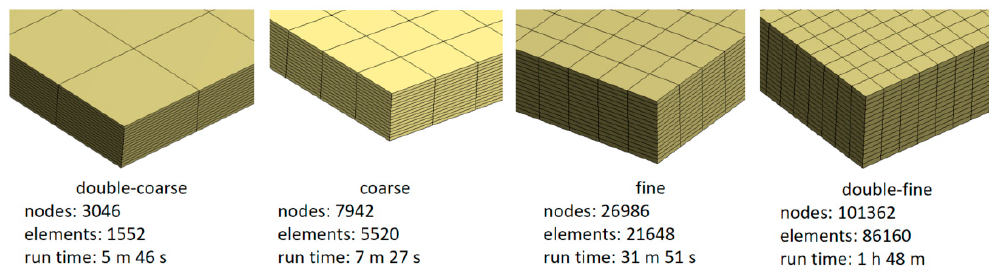
Figure 6. Mesh of the specimen in the numenrical model of the DCB delamination tests .